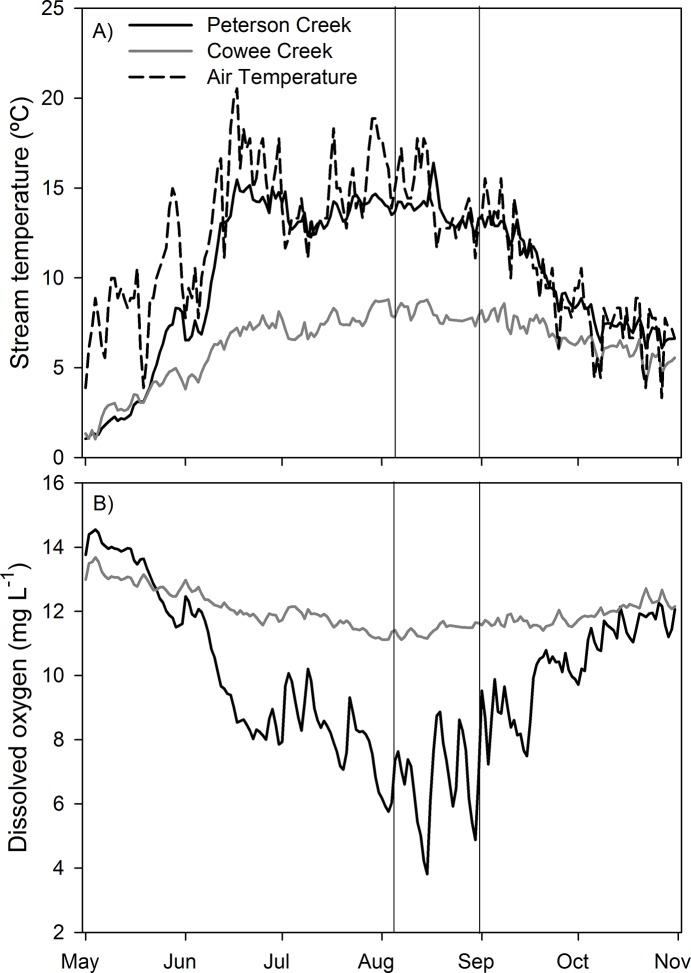
Time series of A) mean daily stream and air temperature and B) DO for the two study watersheds during the 1 May through 31 October, 2013 study period.The two vertical solid lines correspond to the period of time when spawning salmon were abundant in the study streams.